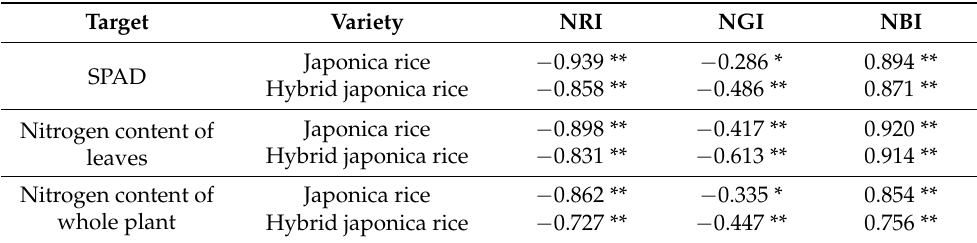
Table 11. Correlations of leaf color index after anthesis in conventional japonica rice and hybrid japonica rice with SPAD, nitrogen content of leaf, and nitrogen content of the whole plant. Target Variety NRI NGI NBI Japonica rice − 0.939 ** − 0.286 * 0.894 ** SPAD Hybrid japonica rice − 0.858 ** − 0.486 ** 0.871 ** Japonica rice − 0.898 ** − 0.417 ** 0.920 ** Nitrogen content of leaves Hybrid japonica rice − 0.831 ** − 0.613 ** 0.914 ** Nitrogen content of whole Japonica rice − 0.862 ** − 0.335 * 0.854 ** plant Hybrid japonica rice − 0.727 ** − 0.447 ** 0.756 **